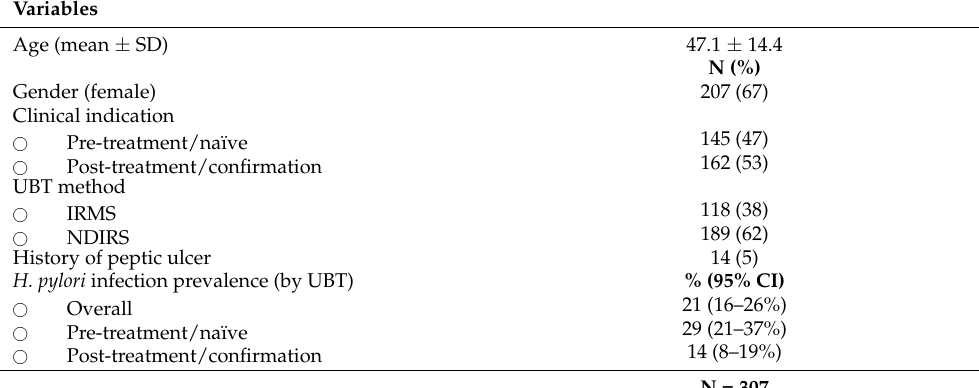
Table 1. Characteristics of the included patients.